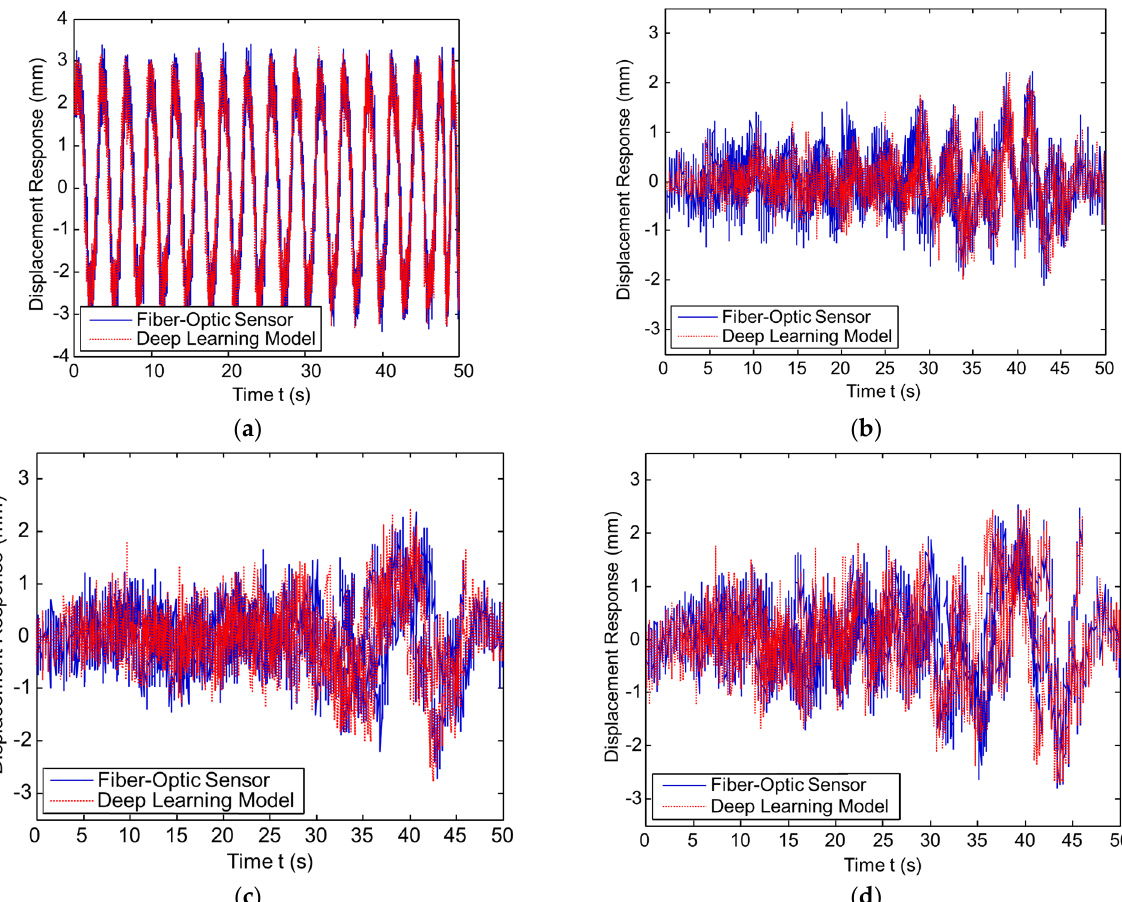
Figure 25. The Displacement response prediction of the UDP and DP under ambient excitation load σ ( x , t ) . ( a ) Response prediction of UDP, D0. ( b ) Response prediction of DP, D1. ( c ) Response prediction of DP, D2. ( d ) Response prediction of DP, D3.